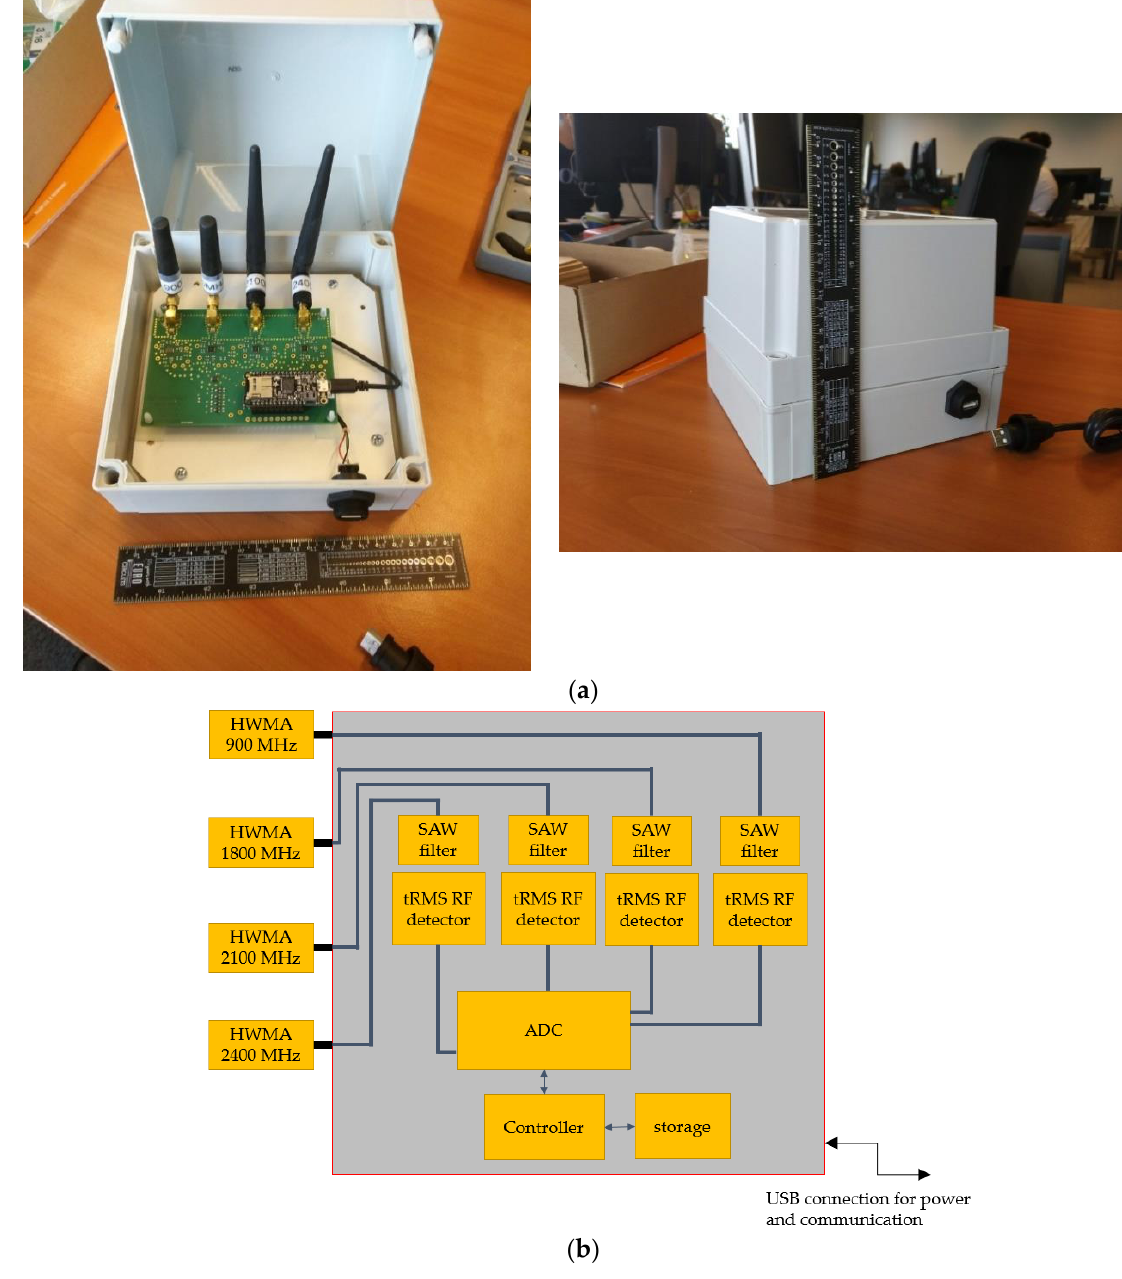
Figure 1. ( a ) The radiofrequency (RF) electromagnetic field (EMF) sensor in its casing. The black stubs are RF-EMF antennas for different frequency bands (Table 1), the green printed circuit board (PCB) is a custom RF-EMF measurement system, the blue PCB is a commercially available communication module with a microcontroller, and the white casing is a custom polyvinylchloride casing; ( b ) Block diagram of the RF EMF sensor. HWMA, half-wavelength monopole antenna; SAW, surface acoustic wave; tRMS, true root-mean-square; ADC, analogue-to-digital convertor; USB, universal serial bus.